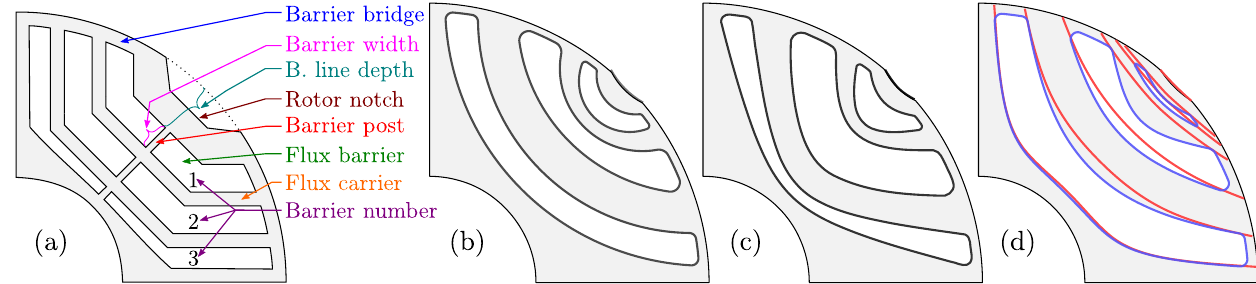
Figure 1. ( a ) SyRM terminology; SyRM rotor barrier types: ( b ) Circular variable depth; ( c ) Hyperbolic variable eccentricity; ( d ) Modified Zhukovsky (blue), original Zhukovsky